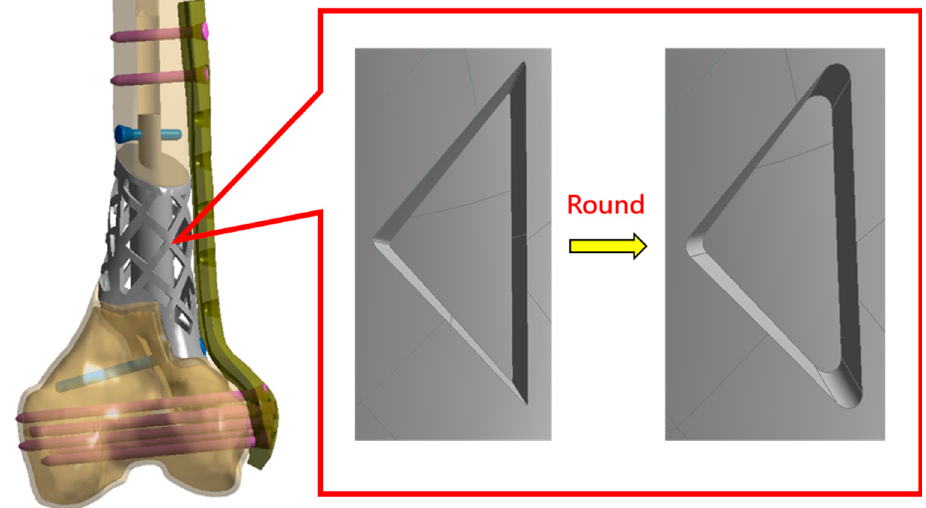
Figure 9. Design optimization of the implant lattice structure from acute angle to rounded angle greatly decreased the implant stress value in the first stage to around 600 MPa, which is much lower than the fracture strength of the titanium alloy material (about 1000 MPa).